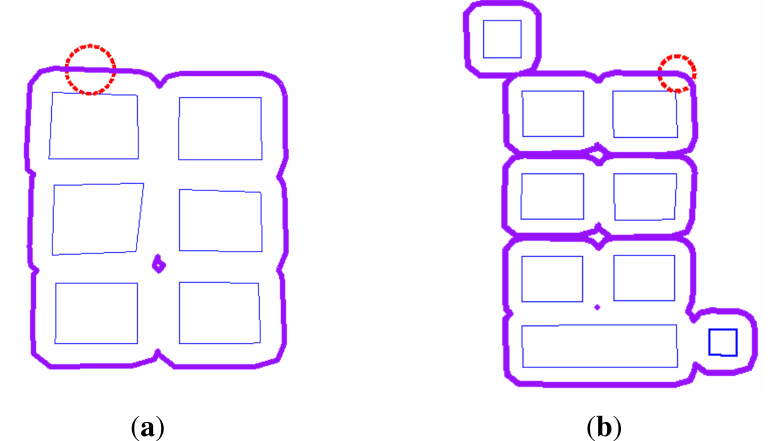
Figure 2. The union of Minkowski sums contains inner rings and self-intersections. ( a ) Union of Minkowski sums with one inner ring (the circle denotes a user); ( b ) self-intersection and inner rings of the Minkowski sums.